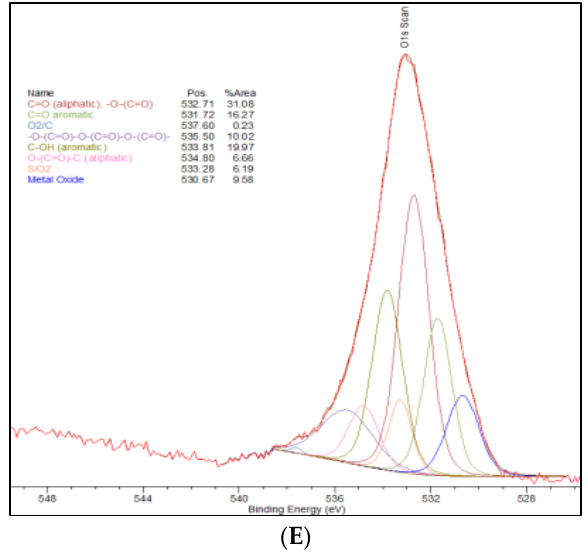
Figure 1. (A ) O1s XPS peak splitting of Commercial AC. ( B ) O1s XPS peak splitting of Standard AC. ( C ) O1s XPS peak splitting of Thermally-Treated AC. ( D ) O1s XPS peak splitting of NH 4+ -Adsorbed AC. ( E ) O1s XPS peak splitting of NH 4+ -Dry AC [19–21].